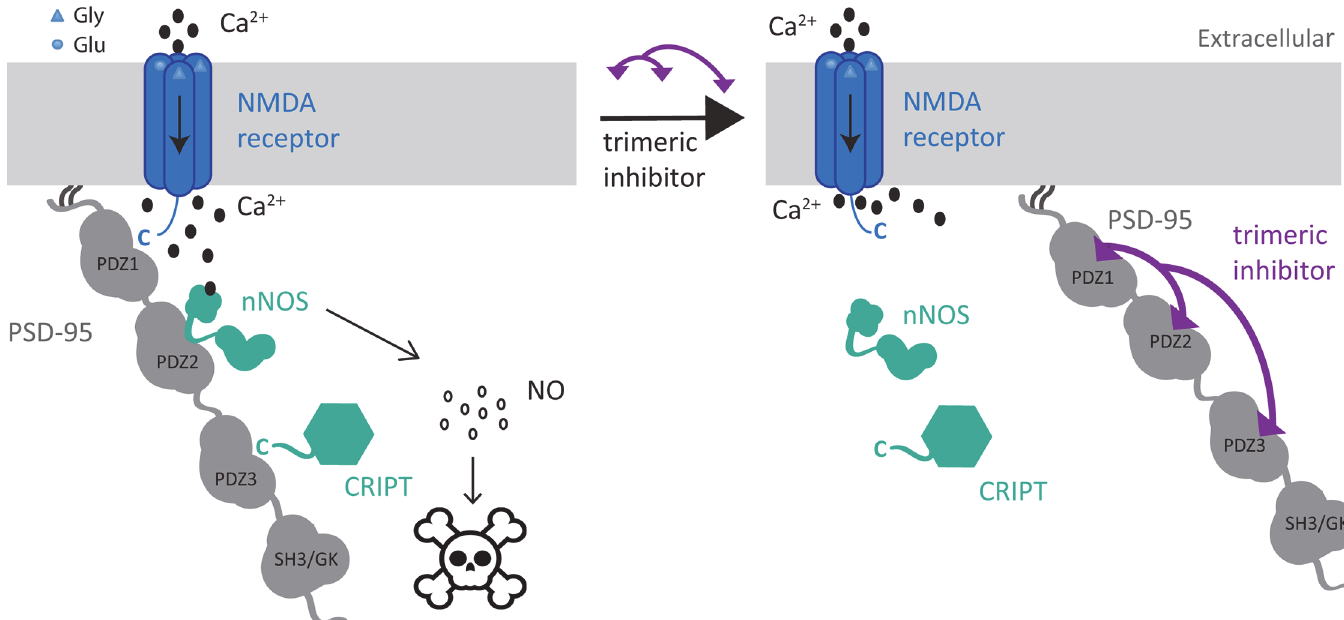
Fig 1. Illustration of the proposed mode of action against excitotoxicity by inhibition of PSD-95. During ischemia and stroke a large amount of glutamate is released, which activates the NMDA receptors. Upon NMDA receptors activation Ca 2+ influx occurs, which stimulate PSD-95 regulated activation of nNOS and the production of NO. By blocking the NMDA receptor/nNOS/PSD-95 complex with a trimeric peptide inhibitor targeting PSD-95, the connection between NMDA receptor activation and toxic NO production is blocked, whereby neuroprotection against excitotoxicity is